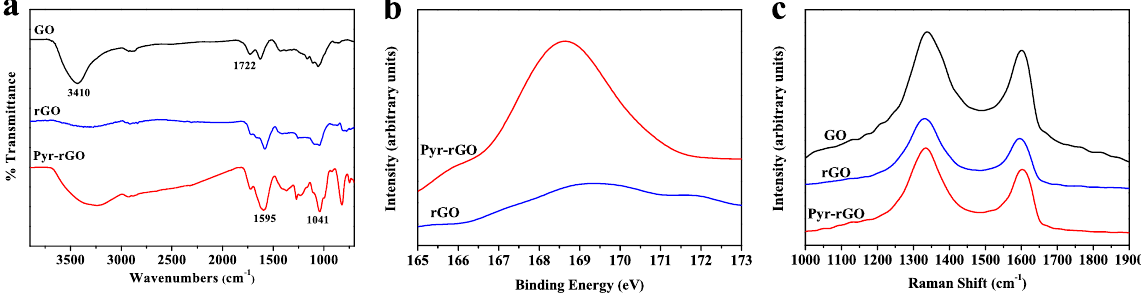
Figure 2. Typical ( a ) FTIR spectra of GO, rGO and Pyr-rGO. ( b ) XPS spectra of the Pyr-rGO and rGO, and ( c ) Raman spectra of the GO, rGO and